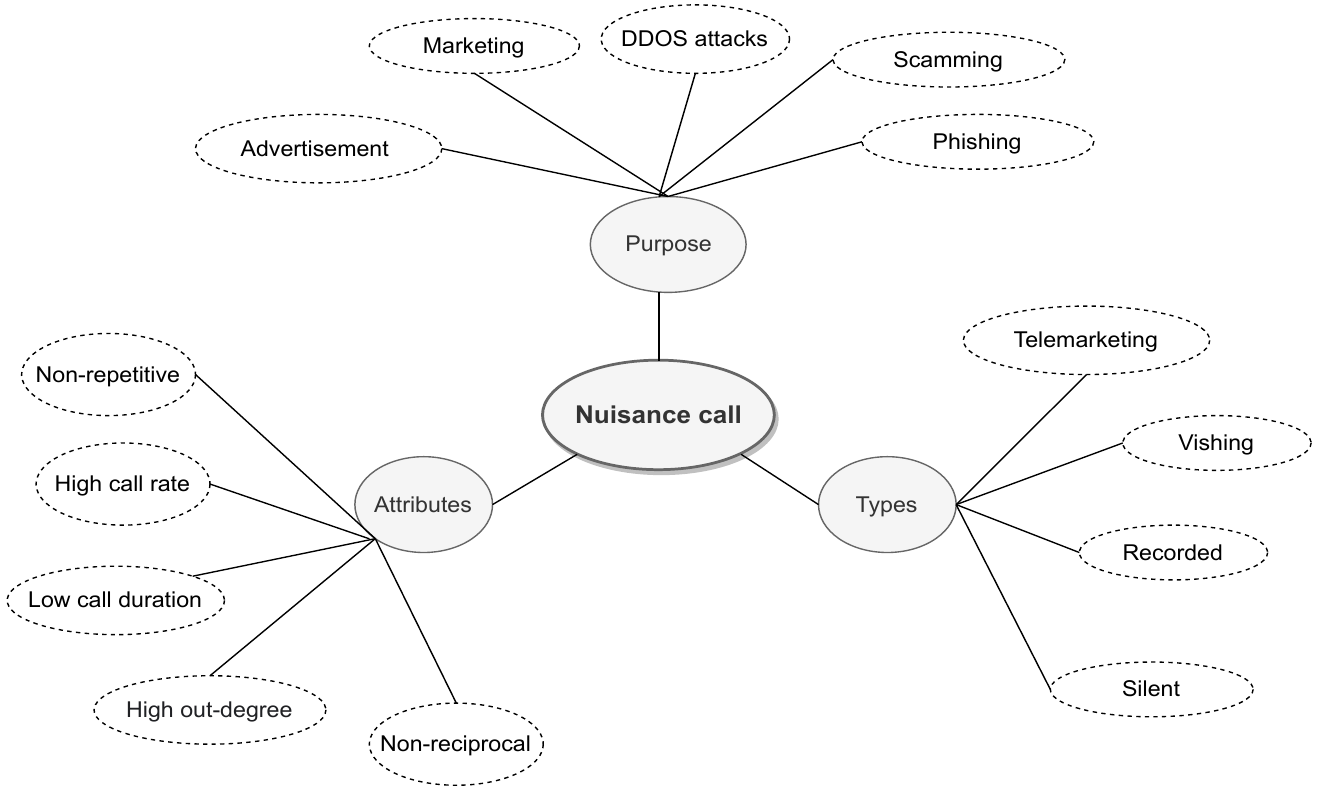
Figure 3. Descriptive model for nuisance